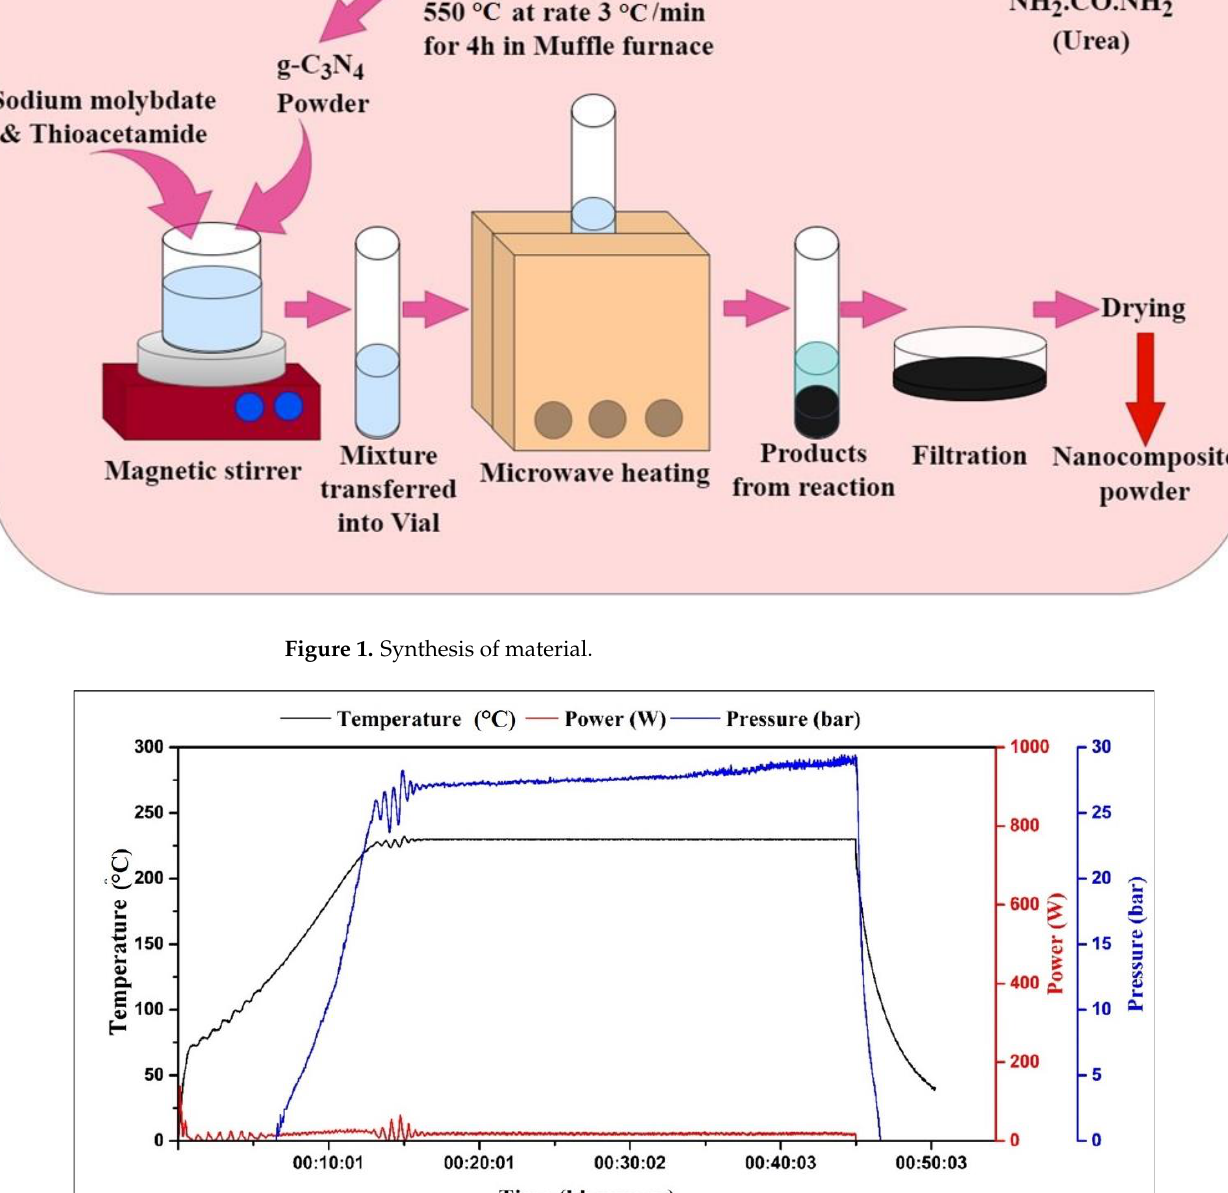
Figure 2. Heat ramp for microwave synthesis.